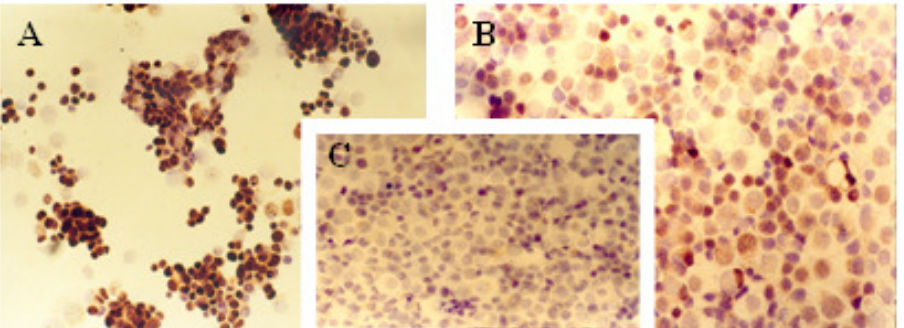
Figure 4. Immunocytochemical study with peroxidase staining of MCF-7 and MCF-7TG cells. Analysis of Ki-67 antigen expression in: A, parental MCF-7cells; B and C, MCF-7TG cells induced with dexamethasone (1 mM) for 2 and 6 days, respectively. (A, C, X 200 magnification; B X 400